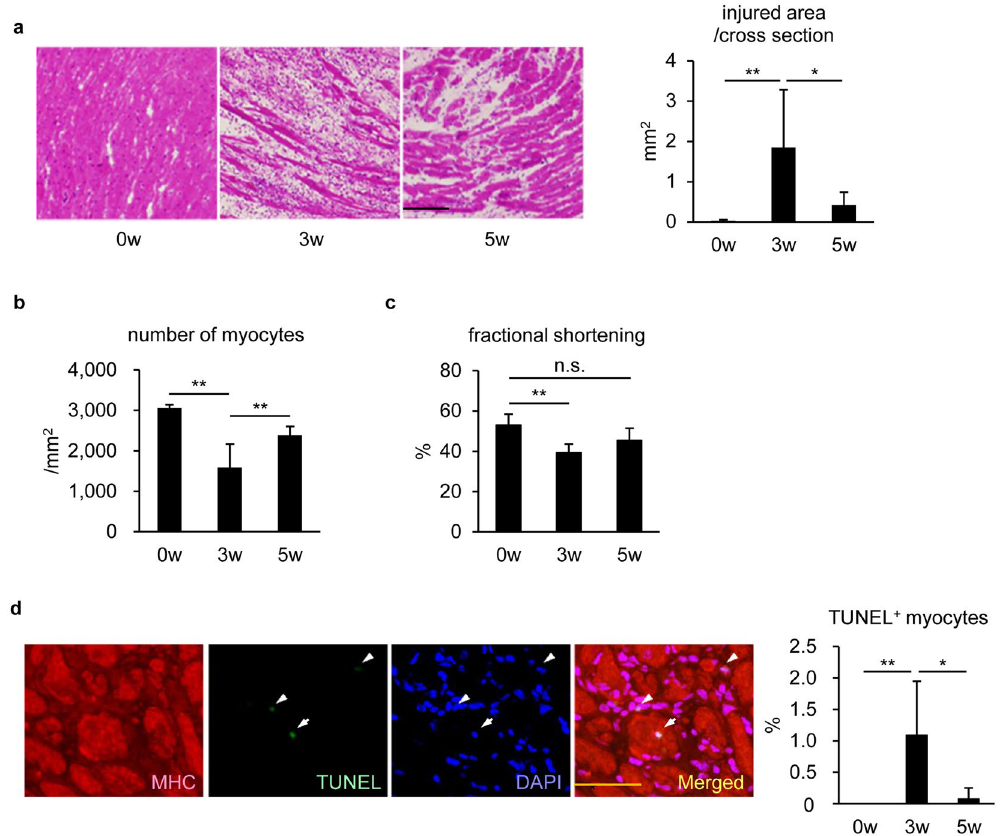
Figure 1. Cardiac tissue was restored from inflammation-induced injury through EAM resolution. ( a ) HE staining was performed for heart sections at the indicated time points after EAM induction. Left: representative images are shown. Scale bar: 100 μ m. Right: injured area was measured. Data were from 6 mice for each group. ( b ) The number of cardiomyocytes was counted in intact, inflamed, and post-inflamed regions at EAM0w, EAM3w and EAM5w, respectively, and the density was calculated. More than 20,000 myocytes were counted from 6 mice for each group. ( c ) Fractional shortening was evaluated by echocardiography at the indicated time points after EAM induction. n = 6 mice for each group. ( d ) TUNEL staining was performed for heart sections at the indicated time points after EAM induction. Left: representative images of a TUNEL + MHC + cell at EAM3w are shown. Arrows: a TUNEL + nucleus in a MHC + cell. Arrowheads: TUNEL + nuclei in MHC − cells. Scale bar: 50 μ m. Right: TUNEL + MHC + cells in the inflamed region were counted and shown as percentage in MHC + cells. n = 5 mice for each group. ( a , b , d ) Kruskal-Wallis test; ( c ) one-way repeated measures ANOVA. * P < 0.05, ** P < 0.01. Data are shown as mean ±